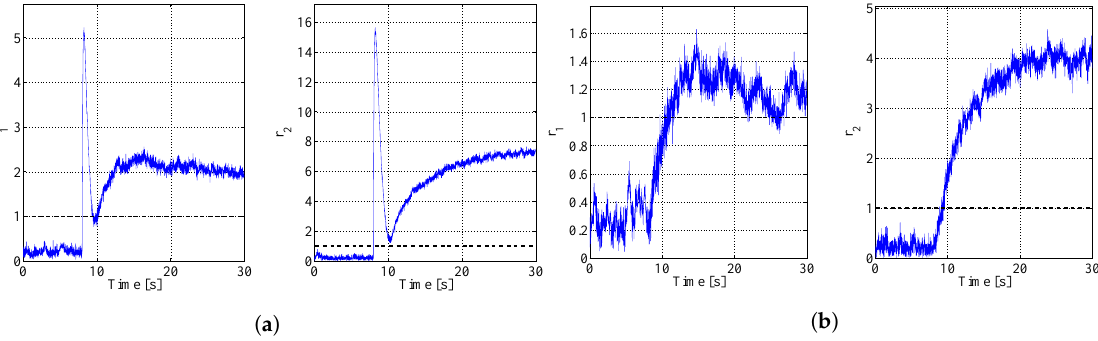
Figure 7. Residuals in case of faults on the static and total air pressure ports: ( a ) Fault on P S = − 150.0 Pa; ( b ) Fault on P T = − 87.9 Pa.